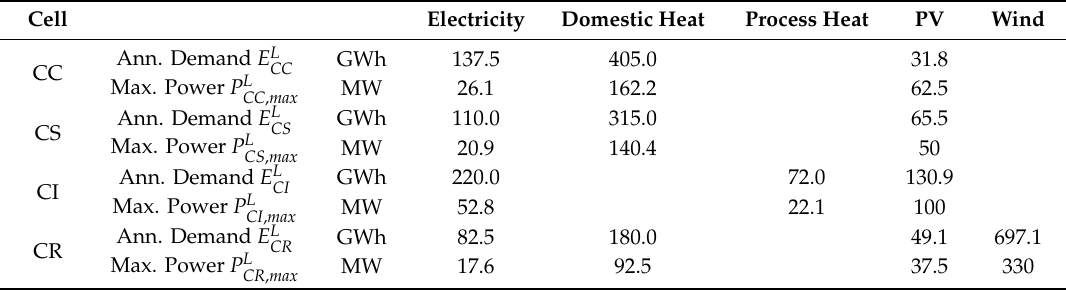
Table 4. Annual demand, annual RES potentials and the corresponding maximum power per cell.